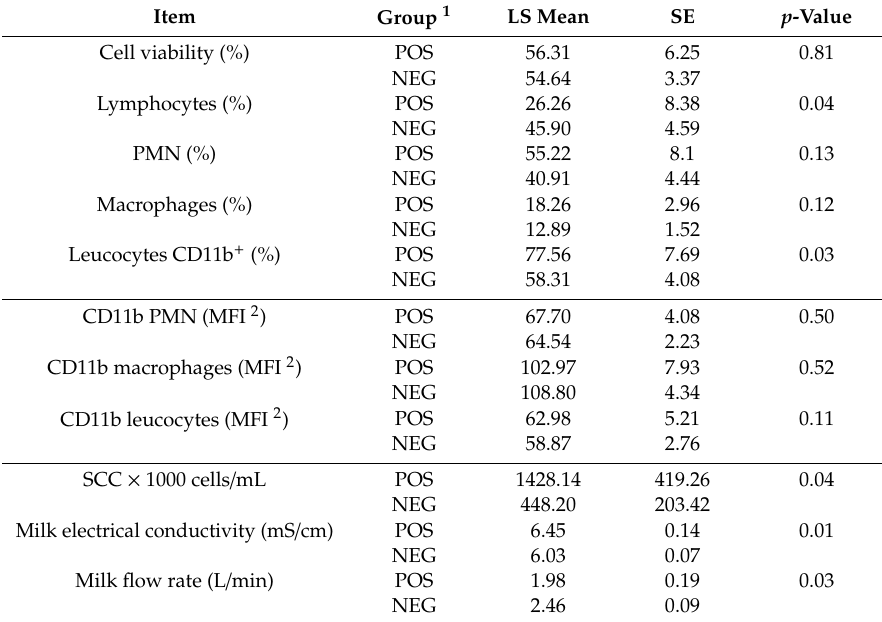
Table 2. Estimated average value of cell viability, milk leukocyte subsets, CD11b expression and automated recorded farm parameters in POS and NEG